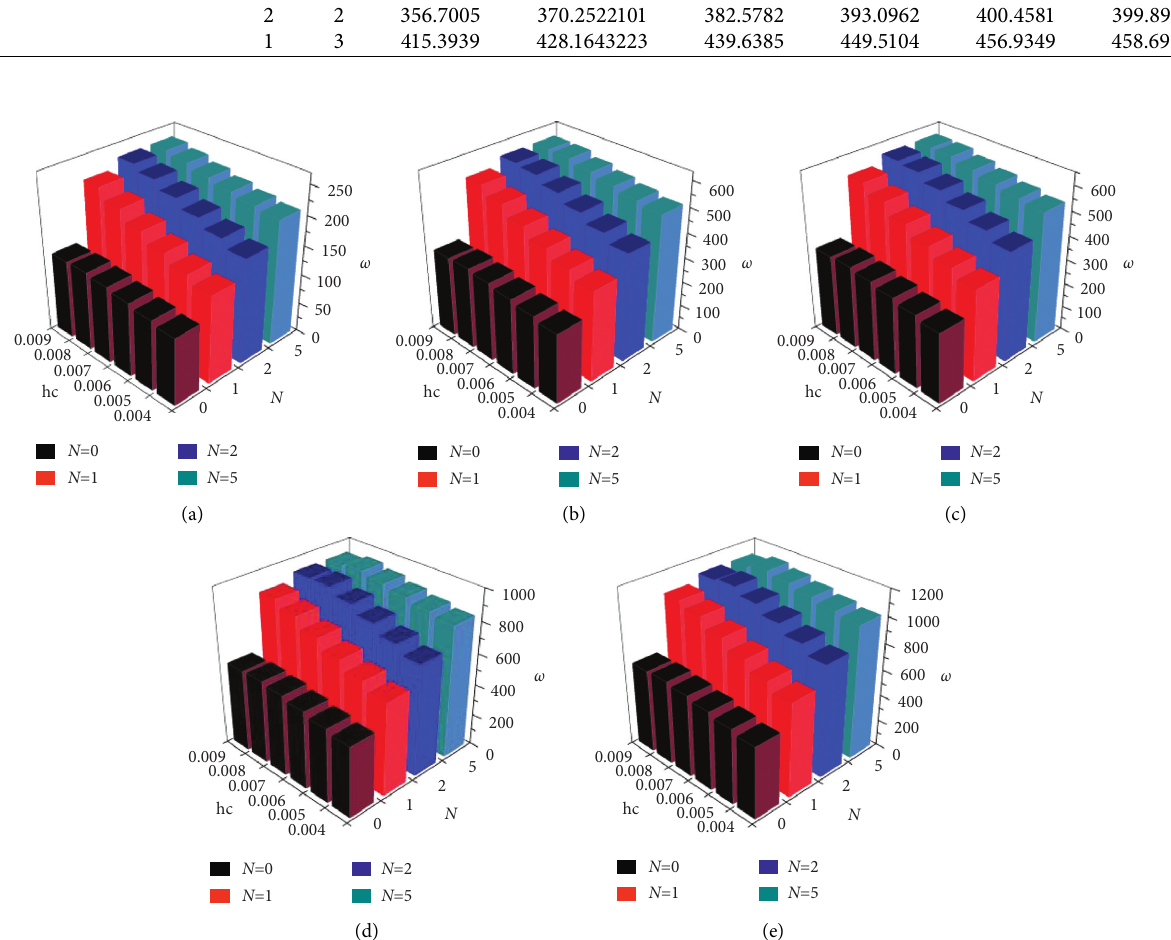
Figure 5: Type A first five natural frequencies ω of the simply supported FGM sandwich plate: (a) 1 st natural frequency, (b) 2 nd natural frequency, (c) 3 rd natural frequency, (d) 4 th natural frequency, and (e) 5 th natural